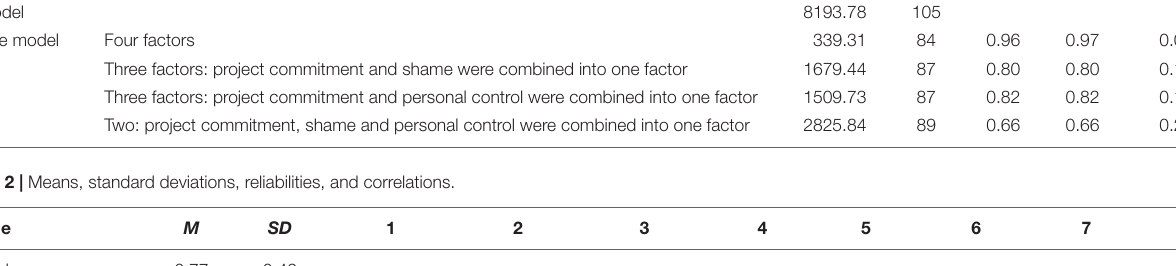
TABLE 1 | Comparison of measurement model.